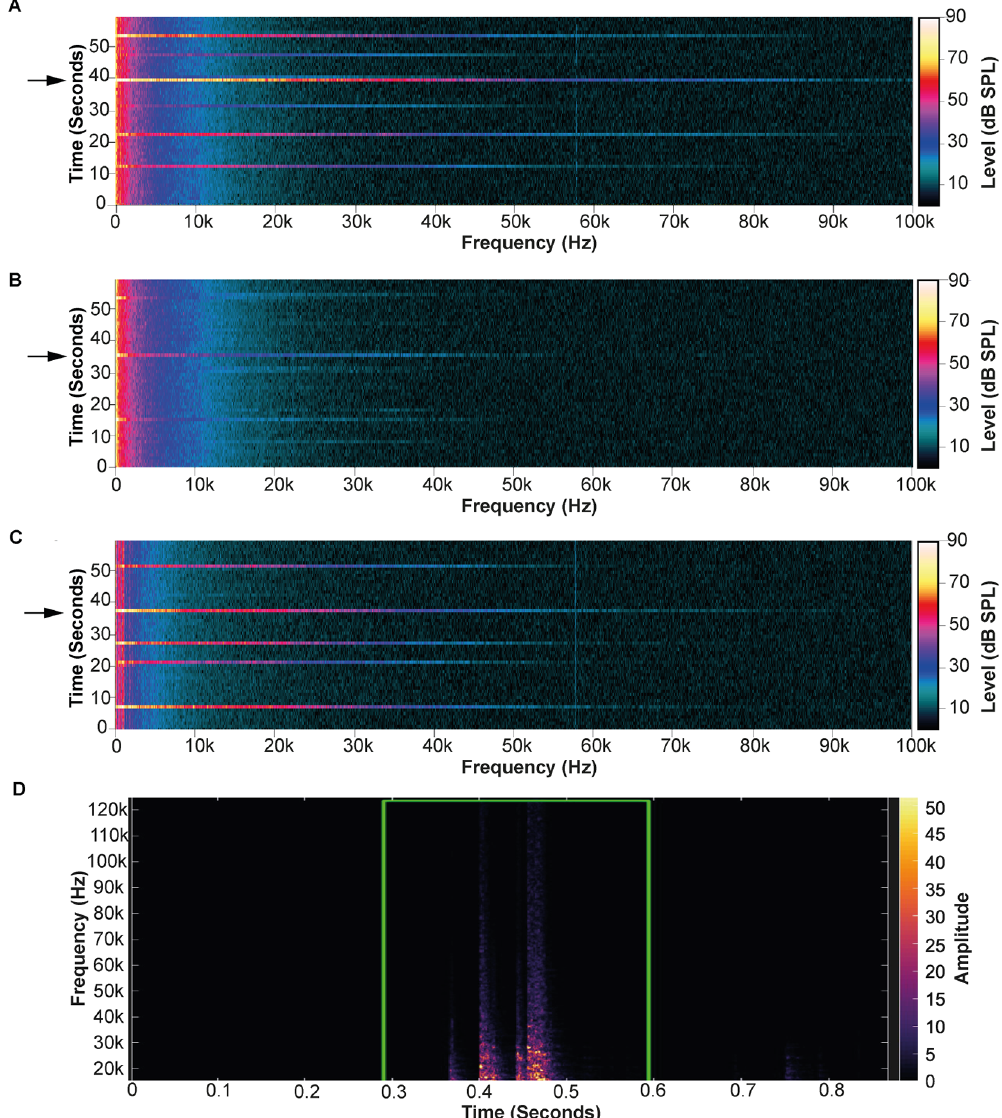
Figure4.Measurements ofthenoiseproducedfromforcepsimpactingsurfaces. A)FastFourierTransform(FFT) autospectrum from the PULSE software showing the noise measured by dropping metal forceps on a metal